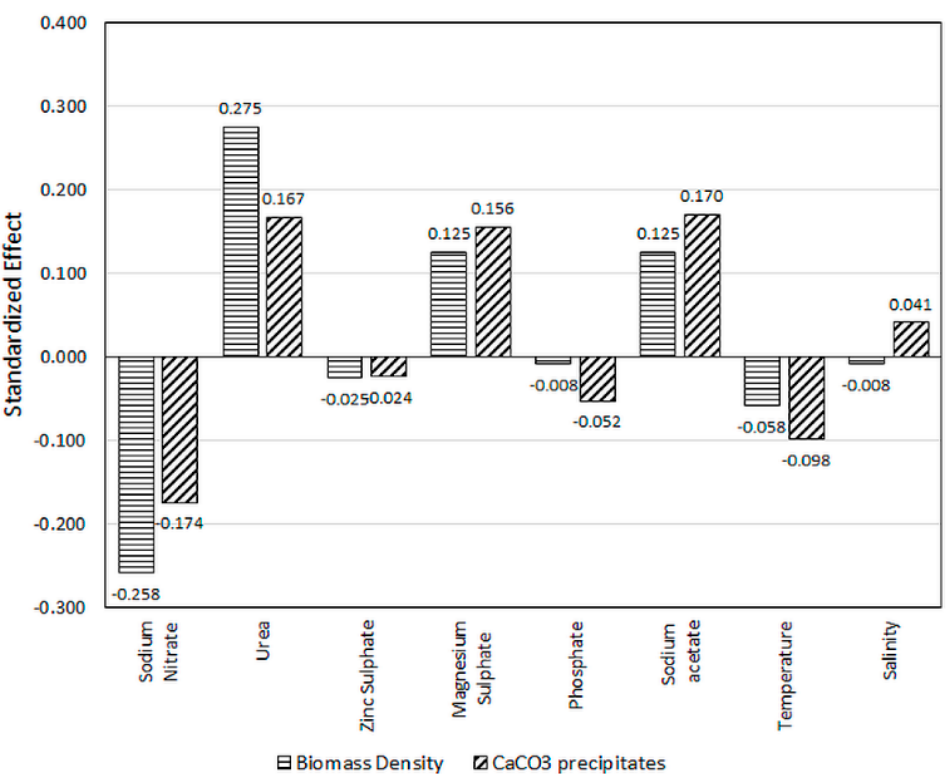
ff ect of di ff erent factors on biomass density and CaCO Figure 1. Effect of different factors on biomass density and CaCO 3 precipitates concentration. Figure 1. E